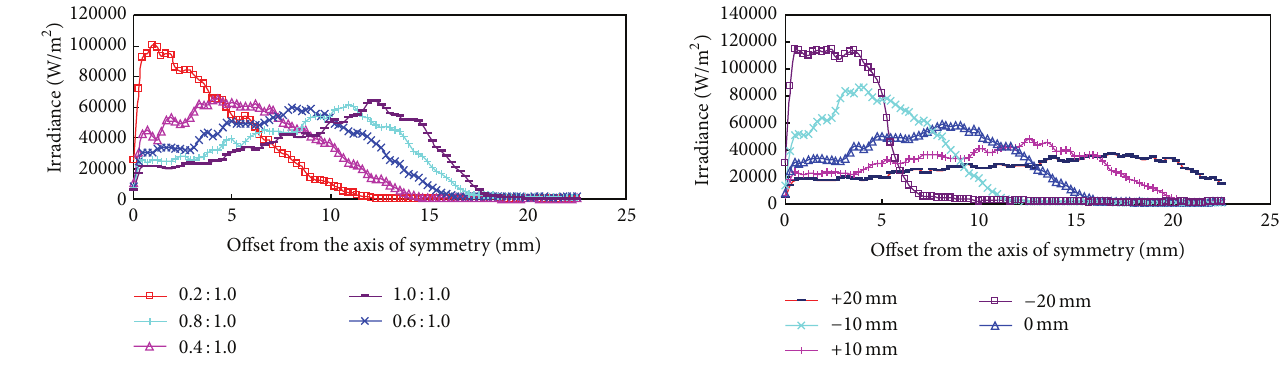
Figure 8: The irradiance distribution of absorbing surface for cavity at different focus offset distance.